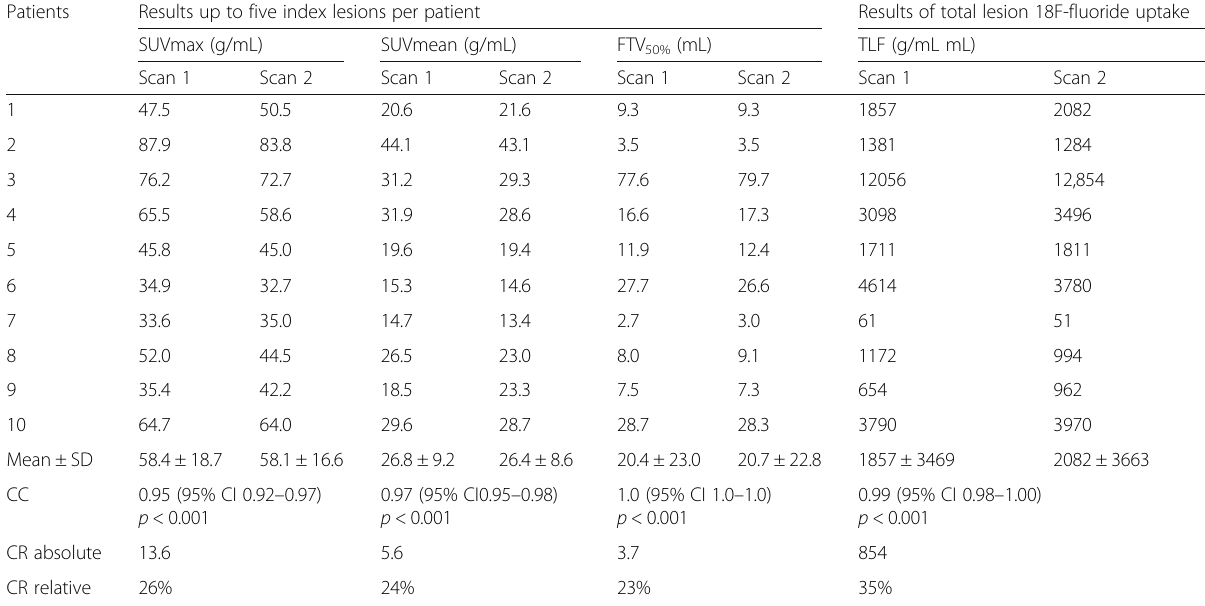
Table 2 Repeatability of 18F-fluoride uptake in index lesions and total lesion 18F-fluoride uptake per patient Patients Results up to five index lesions per